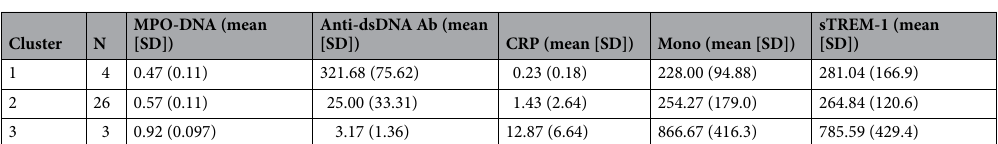
Table 2. Clustering of SLE patients. Patients were grouped using K-means clustering. Data are presented as means. Anti-dsDNA Ab anti-double stranded DNA antibody, CRP C-reactive protein, Mono monocyte, MPO- DNA myeloperoxidase-DNA, SLE systemic lupus erythematosus, SD standard deviation, sTREM-1 soluble TREM-1.